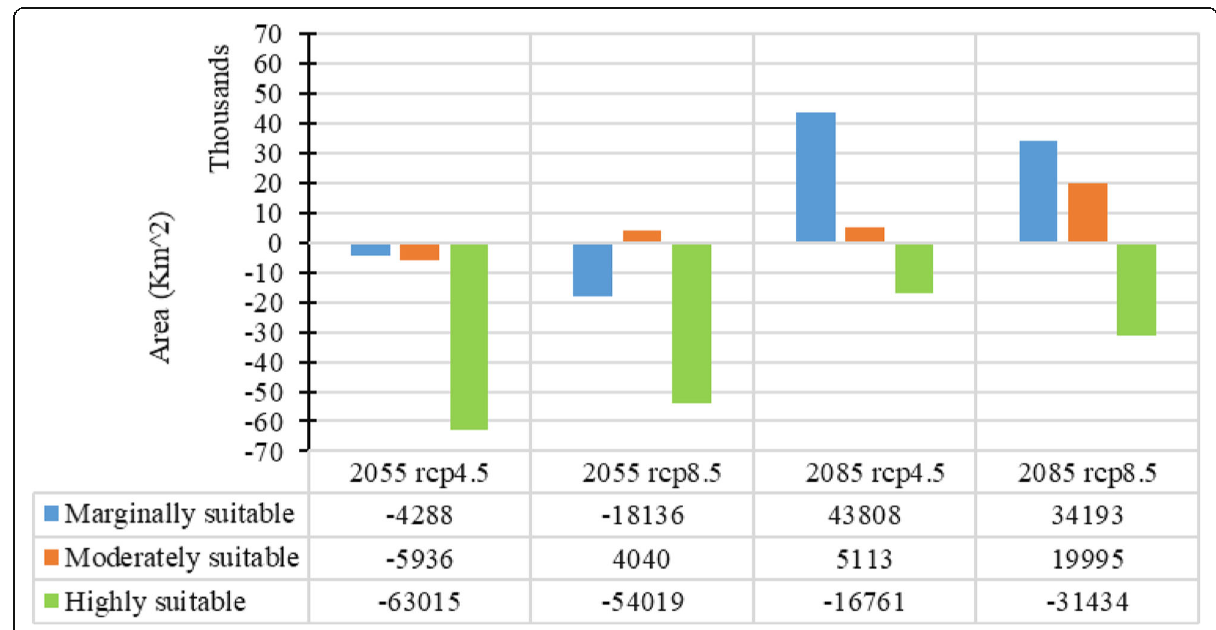
Fig. 5 Estimated potential area (km 2 ) increase or decrease ( − ) from current potential distribution for V. destructor in